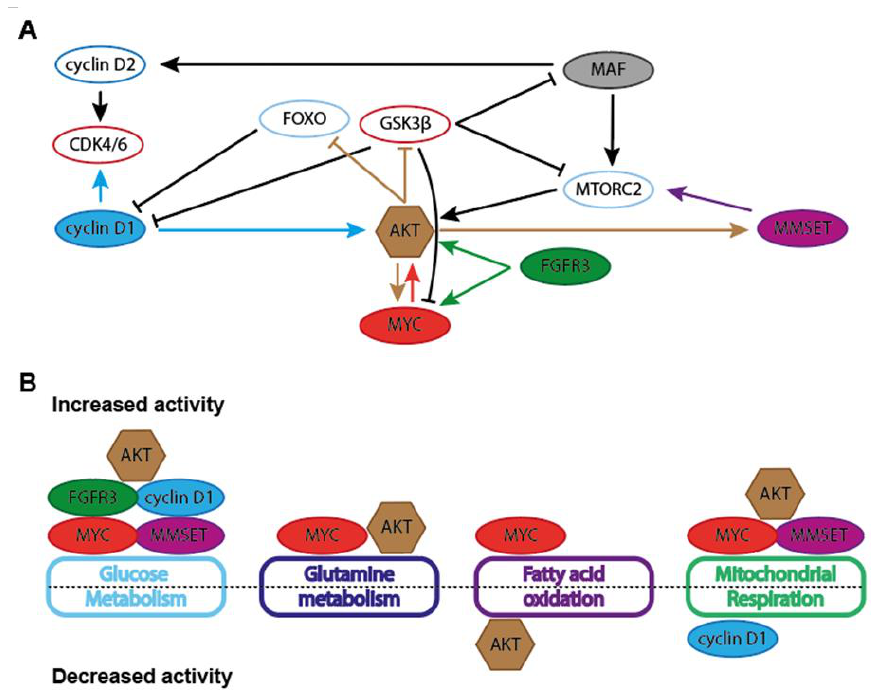
Figure 3. Schematic representation of general metabolic effects of MM-associated oncogenes. ( A ) Interdependencies and functional associations between MYC, cyclin D1, MMSET, FGFR3, AKT and MAF in the regulation of metabolic features in cancer cells. ( B ) Schematic depiction of general effect MM-asociated oncogenes on the activity of several metabolic pathways. Glucose metabolism entails glycolysis, pentose phosphate pathway (PPP), serine synthesis pathway (SSP) and